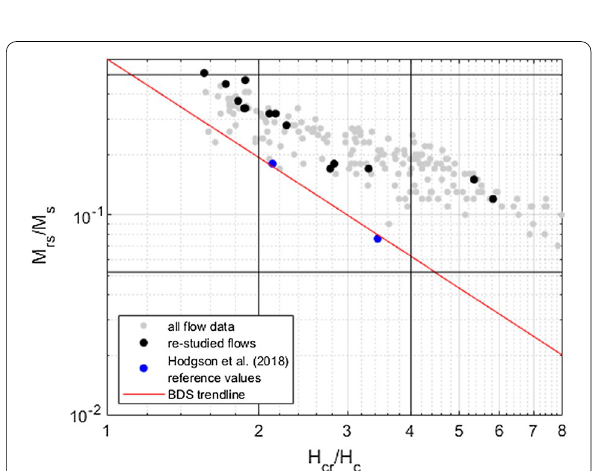
Fig. 3 Bulk domain stability (BDS) plot for the SOH1 flows studied herein. SOH raw data are taken from Gratton et al. (2005) and Russell (2018). Further information on Hodgson et al. (2018) reference values is provided in Table